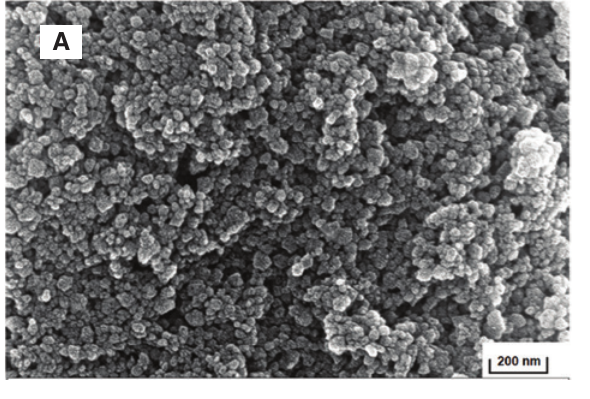
where N is the experimental times, n is the number of vari- ables and c is the central point of the design. 0 Table 1 shows the four-factor design table for the CCD experiments. The experimental data were analyzed by Design-experiment version 8.0 software. Table 2 presents the experimental data and running results. According to the above fitting results, the regression equation is given by